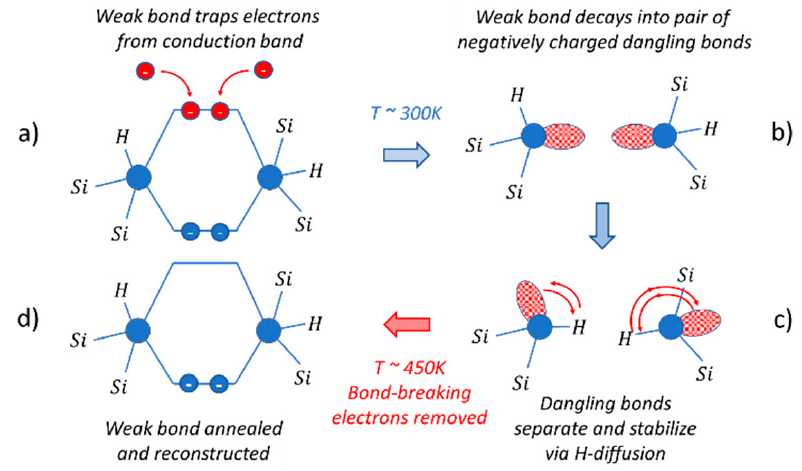
Figure A6. ( a ) Electrons supplied by shallow donors, injected through contacts or induced by field effect become trapped in weak antibonding states and cause weak bonds to convert in pairs of negatively charged dangling bonds ( b ) [56,57]. Dangling bonds are once again separated and stabilized via H-diffusion forming metastable conduction states ( c ). At room temperature, metastable conduction states slowly relax after the bond-breaking electrons have disappeared ( d ) [60,61].